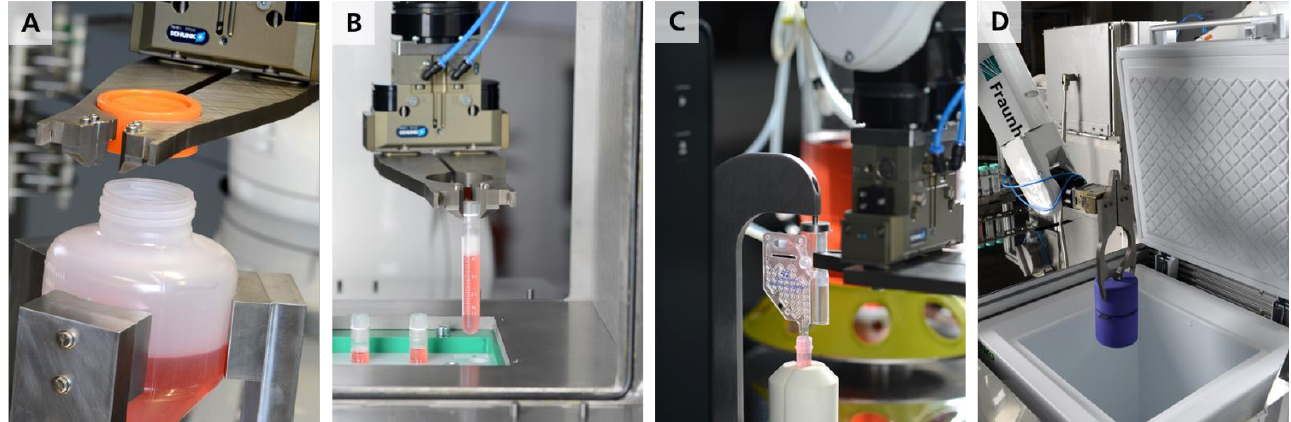
Figure 1. Gripping of different materials of the robots in the AUTOSTEM platform [21]. ( A , B ) show the robot in the sterile platform area while ( C , D ) show the other robot in the unsterile area.